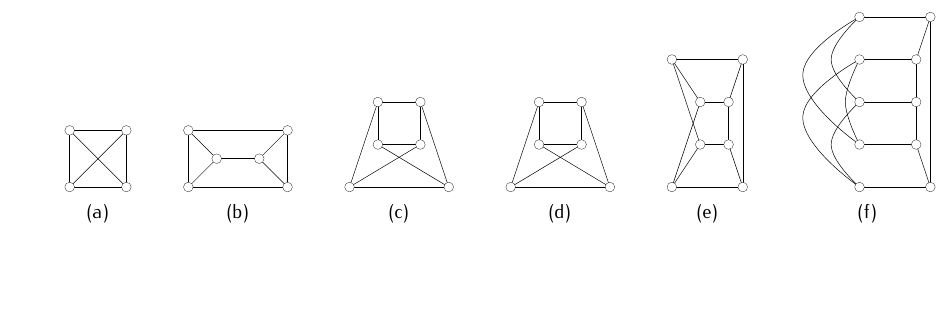
Figure 3. Cubic ˆ s -expandable